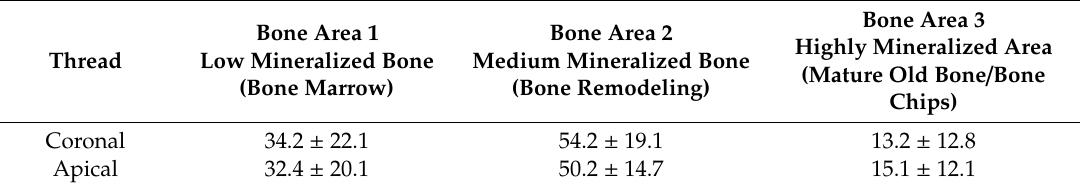
Table 4. Type of bone area detected at the implant–bone interface detected along the coronal and apical portion, calculated as percentages (Mean ± SD). N = 8 implants. No statistically significant differences were reported among coronal and apical ROI (p < 0.05).